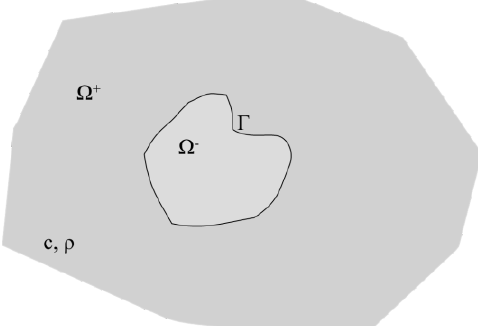
Figure 1. General scheme of the analyzed problem with a cavity inside an infinite homogeneous acoustic medium.